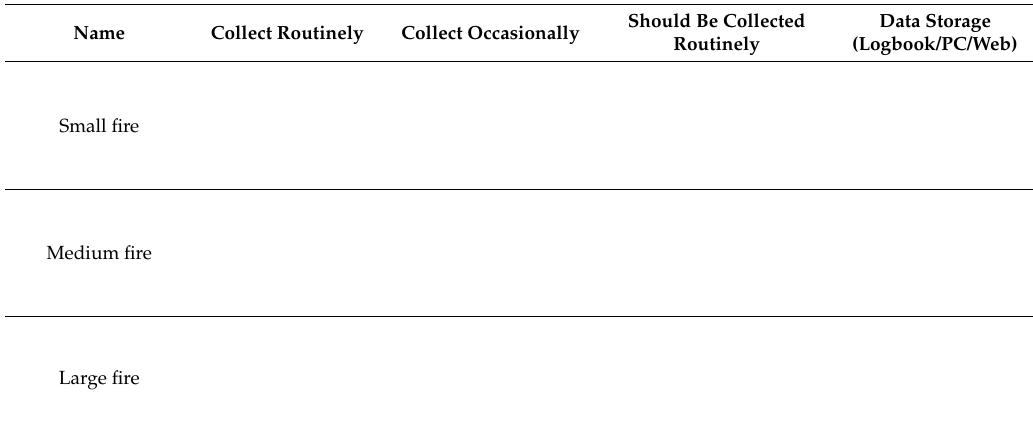
Table A2. What kind of data are you collecting during an